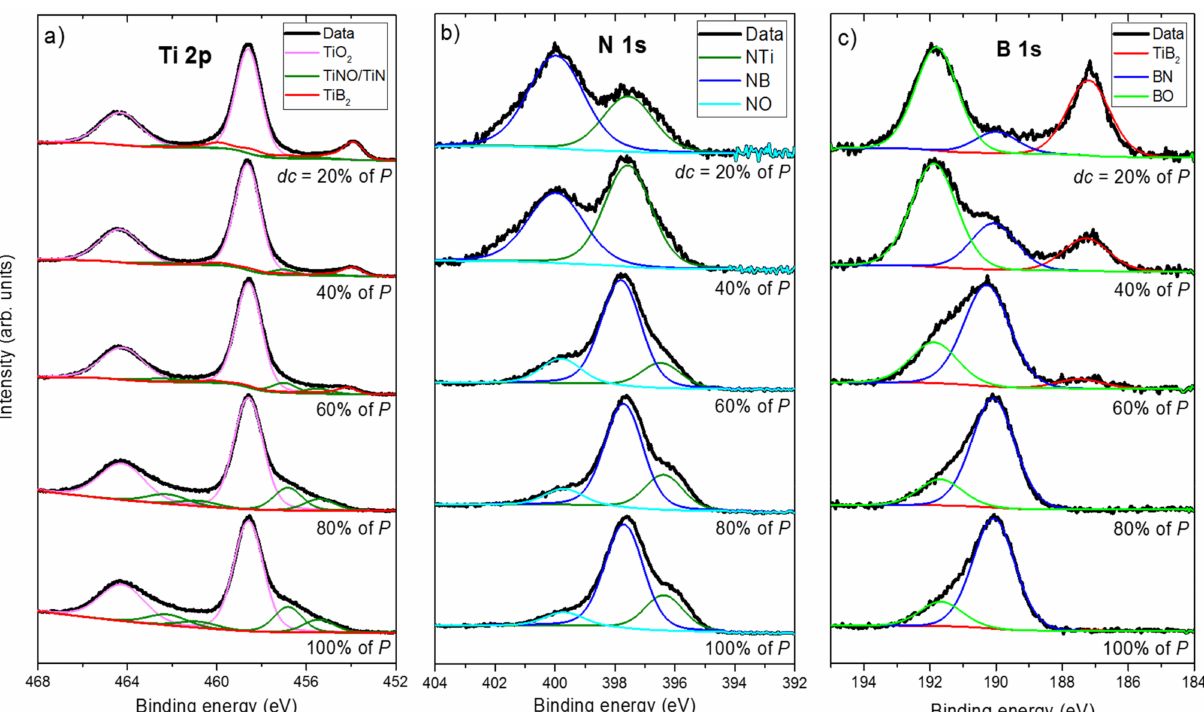
Figure 2. XPS spectra of ( a ) Ti 2p, ( b ) N 1s and ( c ) B 1s of Ti-B-N thin films prepared with various duty cycles ( dc